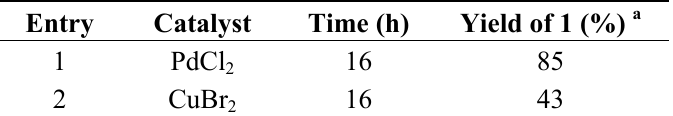
Table 4. Deprotection of DPM ethers in ethanol at 85 °C.